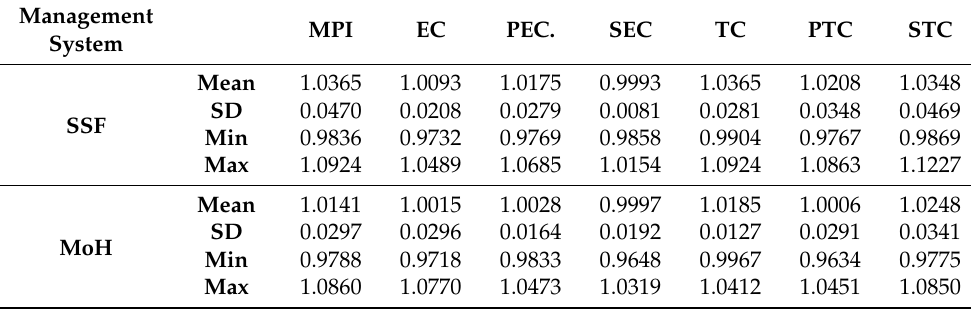
Table 6. Differences in descriptive statistics by type of management (2005–2015).